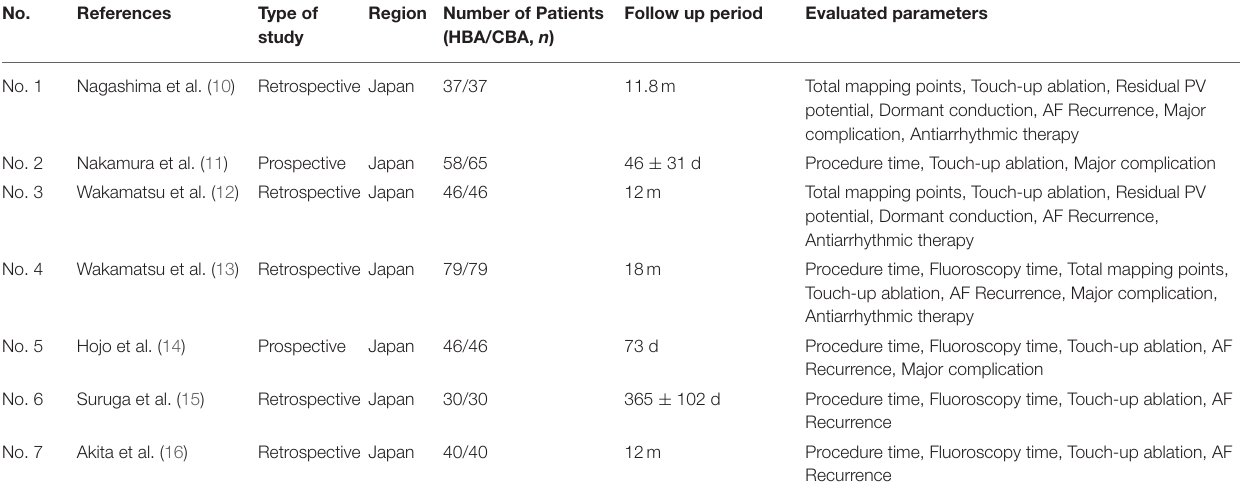
TABLE 1 | Main characteristics of 7 eligible studies included in the